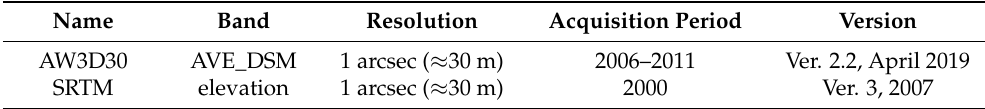
Table 1. Datasets for building height